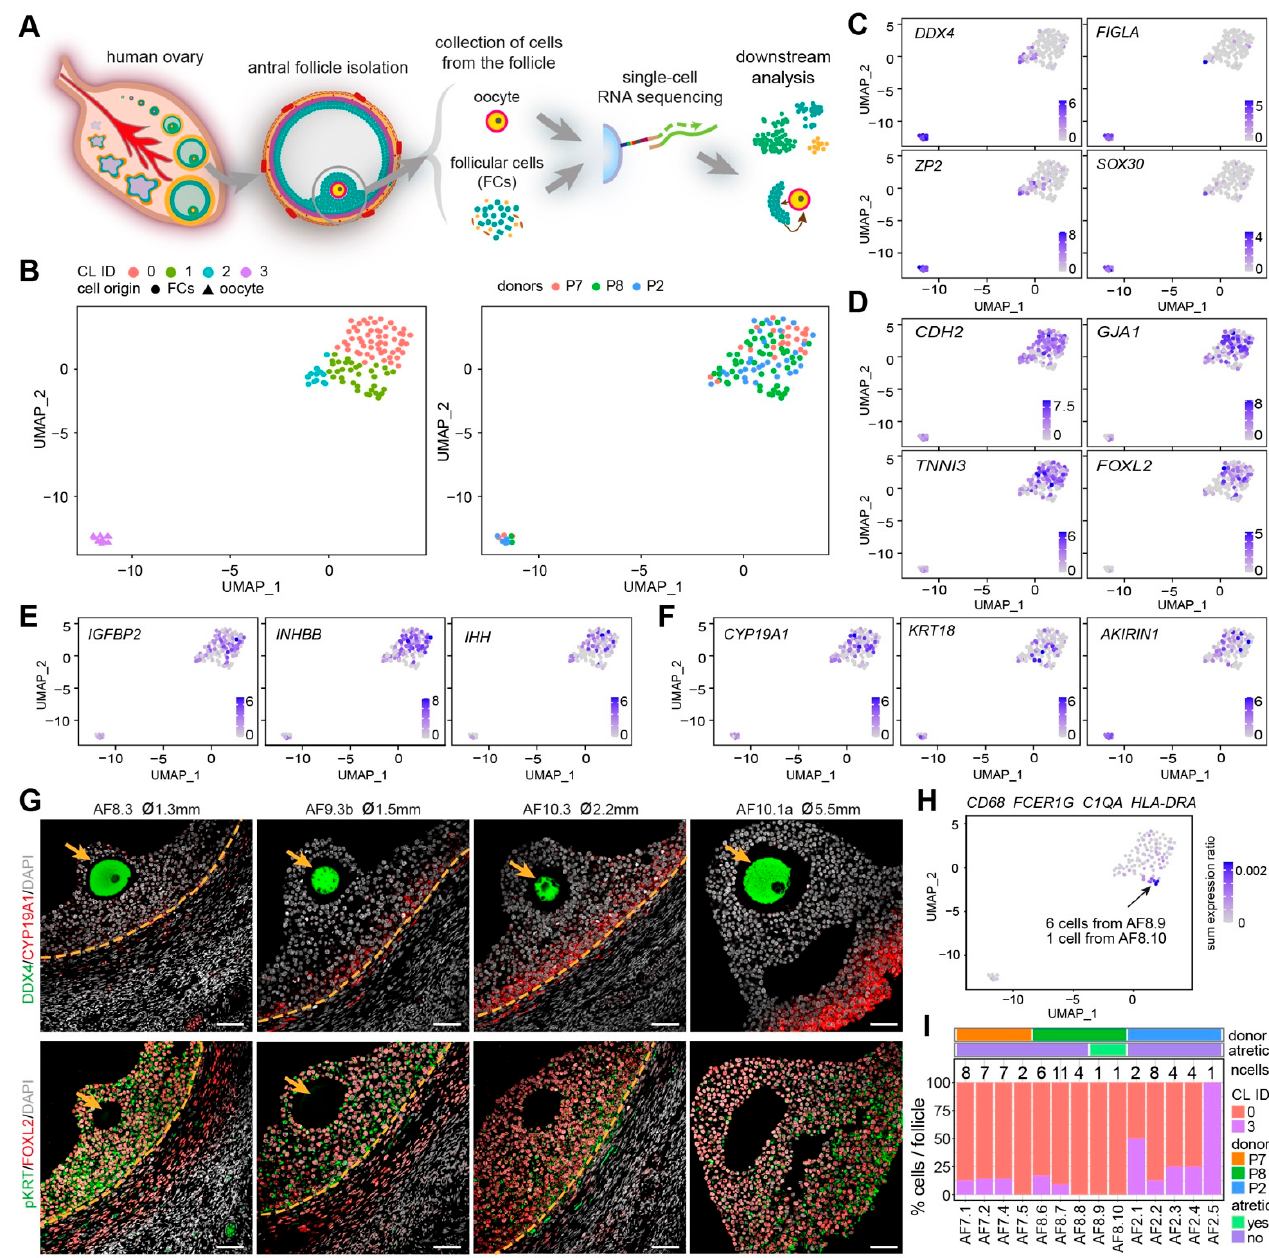
Figure 2. Identification of oocytes and granulosa cells from small human antral follicles. ( A ) Schematic illustration of the study design; ( B ) Uniform manifold approximation and projection (UMAP) plots showing 4 clusters of cells (left panel), colored by donors (right panel); ( C ) Expression of oocyte markers on the UMAP plot; ( D ) Expression of general granulosa cell (GCs) markers on the UMAP plot; ( E ) Expression of cumulus GC markers on the UMAP plot; ( F ) Expression of mural GC markers on the UMAP plot; ( G ) Immunofluorescence for DDX4 and CYP19A1 (top panels); and pan-cytokeratin (pKRT) and FOXL2 (bottom panels) on small human antral follicles showing the follicle area close to the oocyte. Orange arrows indicate the oocyte. Orange dashed lines indicate the follicular basement membrane. ø, follicle diameter. Scale bars are 50 μ m; ( H ) Combined expression of selected immune markers on the UMAP plot; ( I ) Percentage of oocytes (CL3) and GCs (CL0) per small antral follicle.